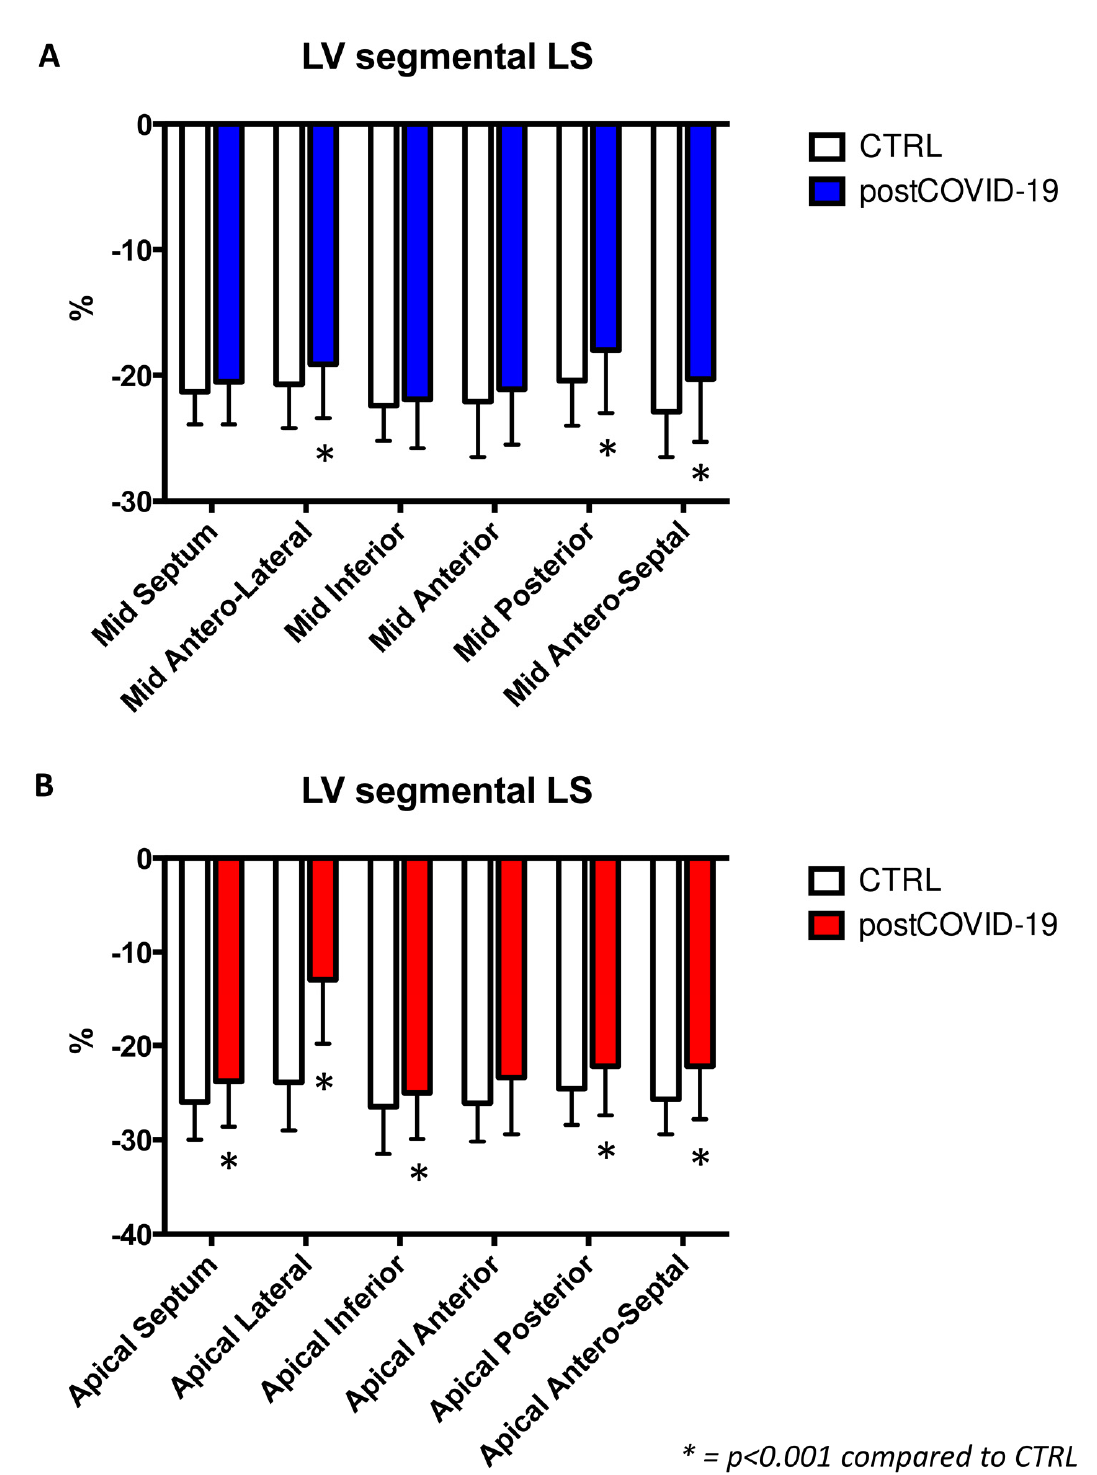
Figure 2. The mid ( A ) and apical ( B ) LV segmental analysis illustrated in detail. Thirty-seven post-COVID-19 children reached a follow-up of >240 days since the acute onset of the disease, with a mean GLS of − 20.1 ± 2.8%. Overall, 28 children were examined at a follow-up of 180–240 days with a mean GLS of − 20.6 ± 4.4%, and the remaining